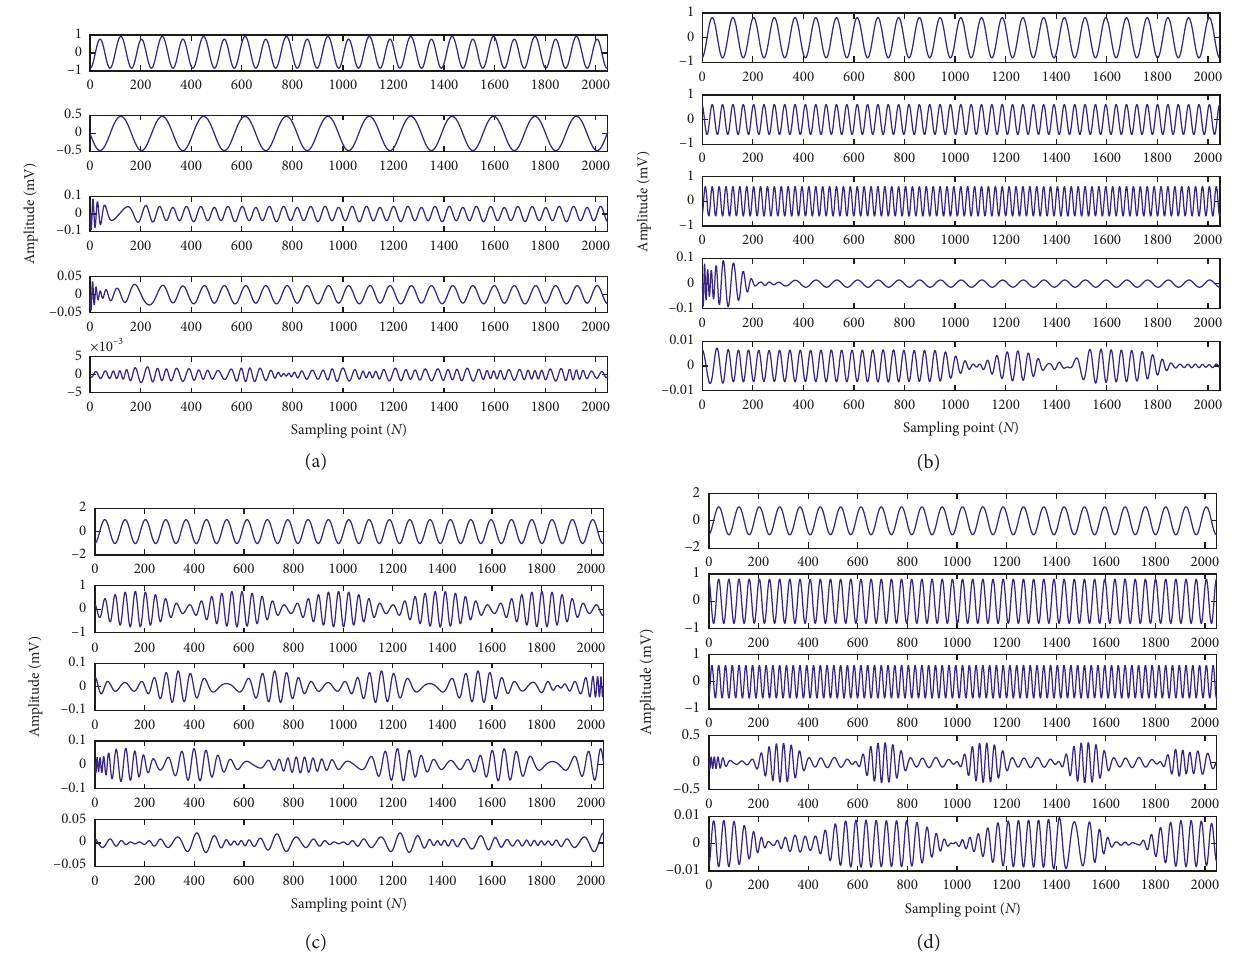
Figure 5: Results of KL-HVD of various simulation signals. (a) KL-HVD result of signal x HVD result of signal x 3 ( t ). (d) KL-HVD decomposition result of signal x 4 ( t